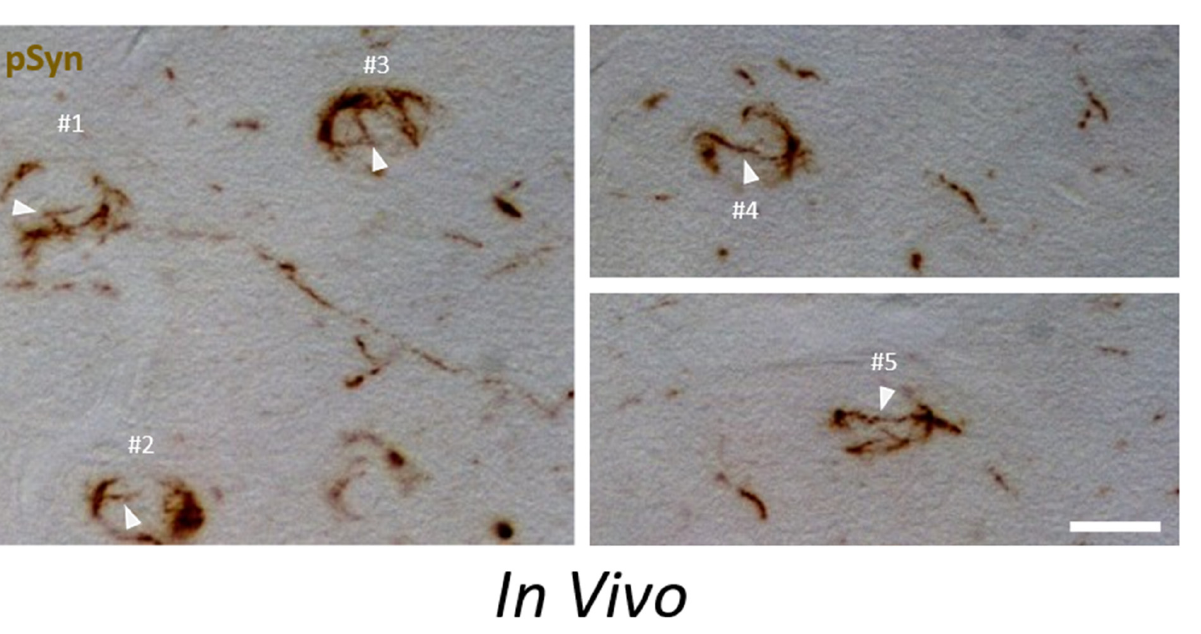
Figure 10. IHC of the α -Syn pathology in a mouse injected 1 month before with 1B fibrils. Paraffin section. Phospho-S129 α -Syn: brown. Zone injected with 1B: right striatum, zone sampled in the images: ipsilateral entorhinal cortex. Five neurons (#1 to #5) bearing NIIs (plain arrowheads) and NCIs are shown. For description see text. Scale bar: 10 μ m.